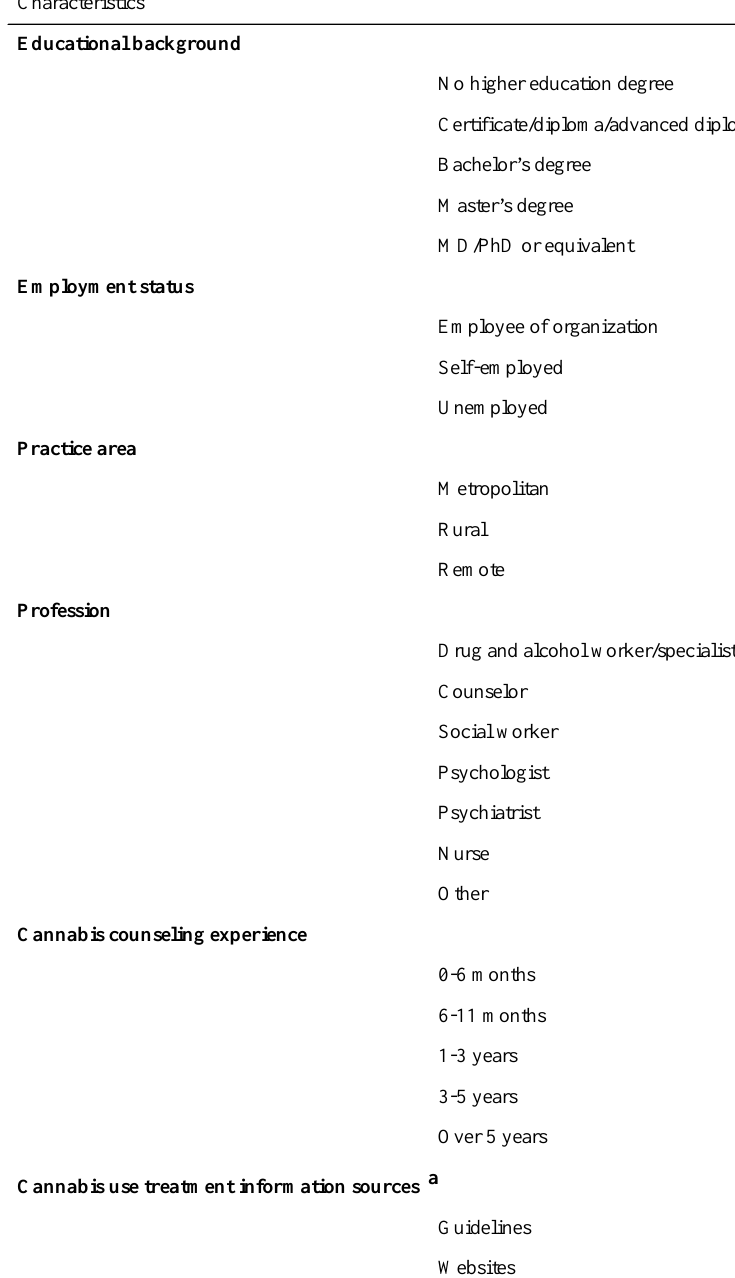
Table 3. Educational and professional characteristics of the participants (N =